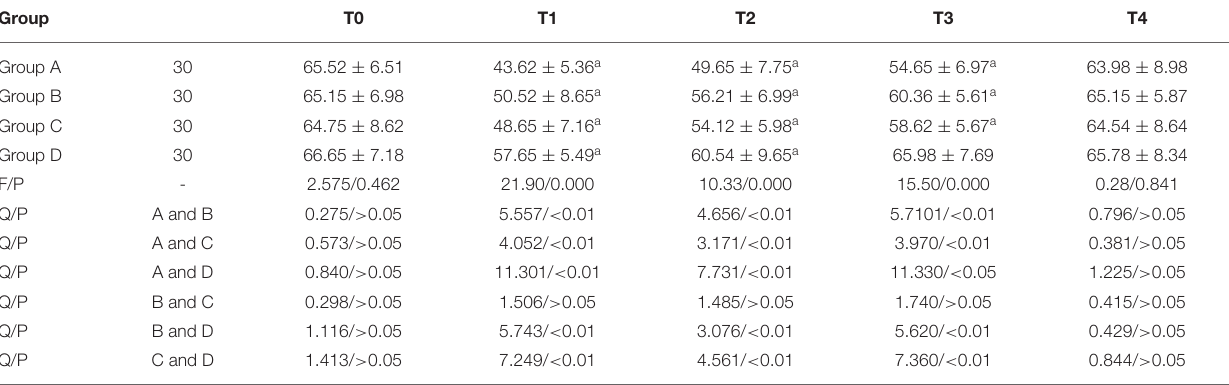
TABLE 1 | Comparison of CD3 + expression among four groups (¯X ± s).